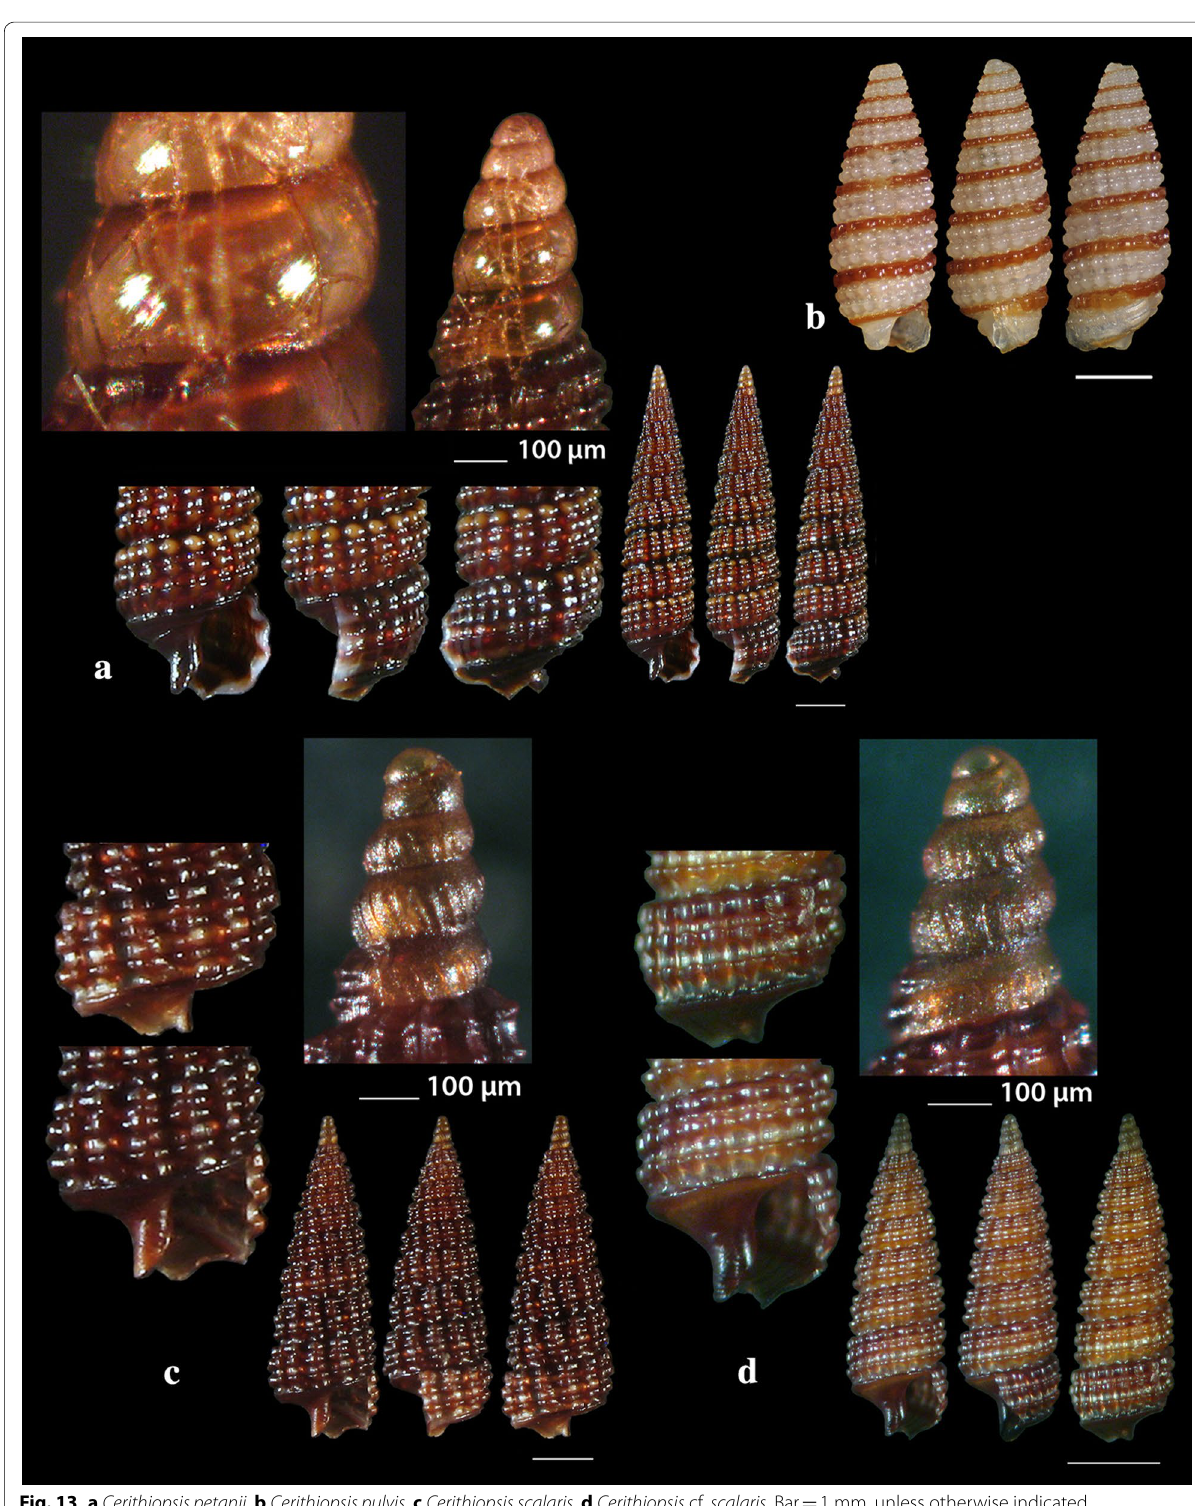
Fig. 13 a Cerithiopsis petanii , b Cerithiopsis pulvis , c Cerithiopsis scalaris , d Cerithiopsis cf. scalaris . Bar